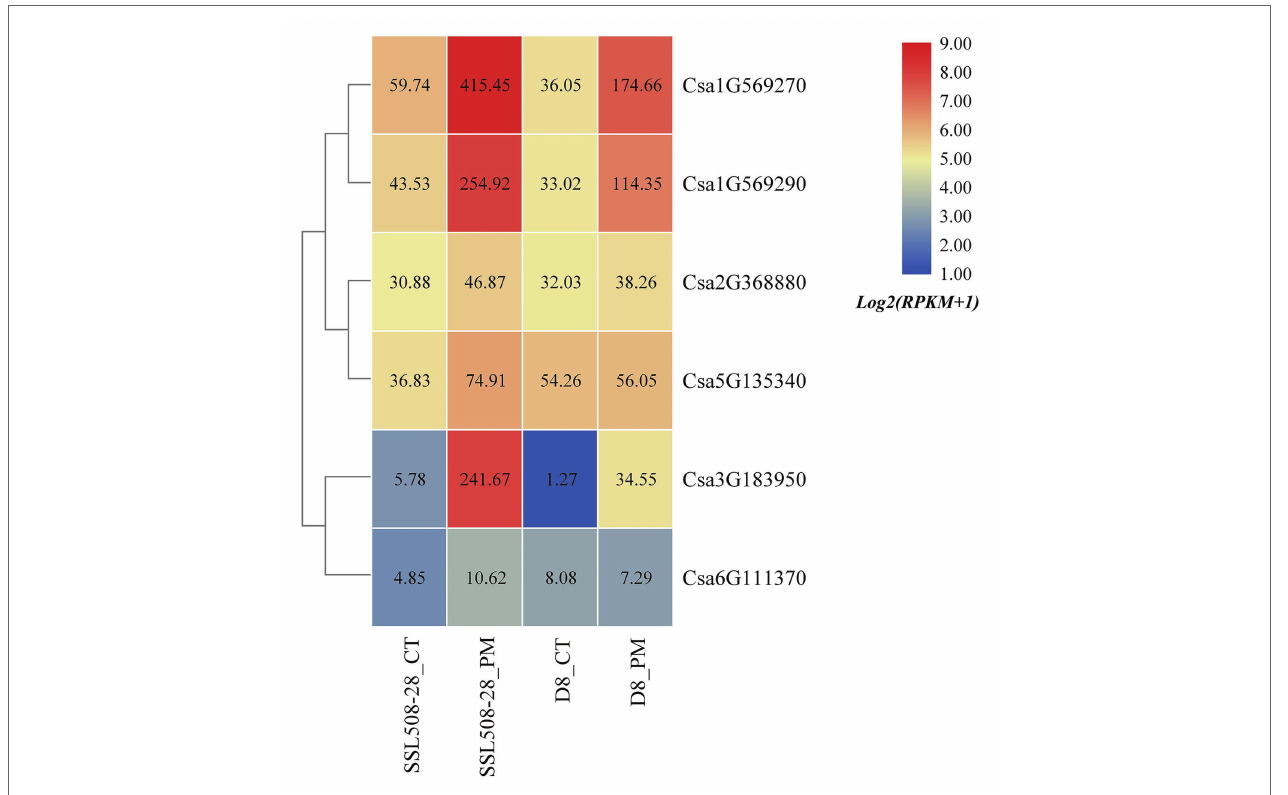
FIGURE 10 | The expression heatmap of the cucumber HSP90 gene family under the treatment of powdery mildew inoculation. SSL508-28 is the powdery mildew resistant cucumber plant; D8 is the powdery mildew susceptible cucumber plant. CT is the control sample. PM means powdery mildew inoculation. The data in the boxes indicate original RPKM